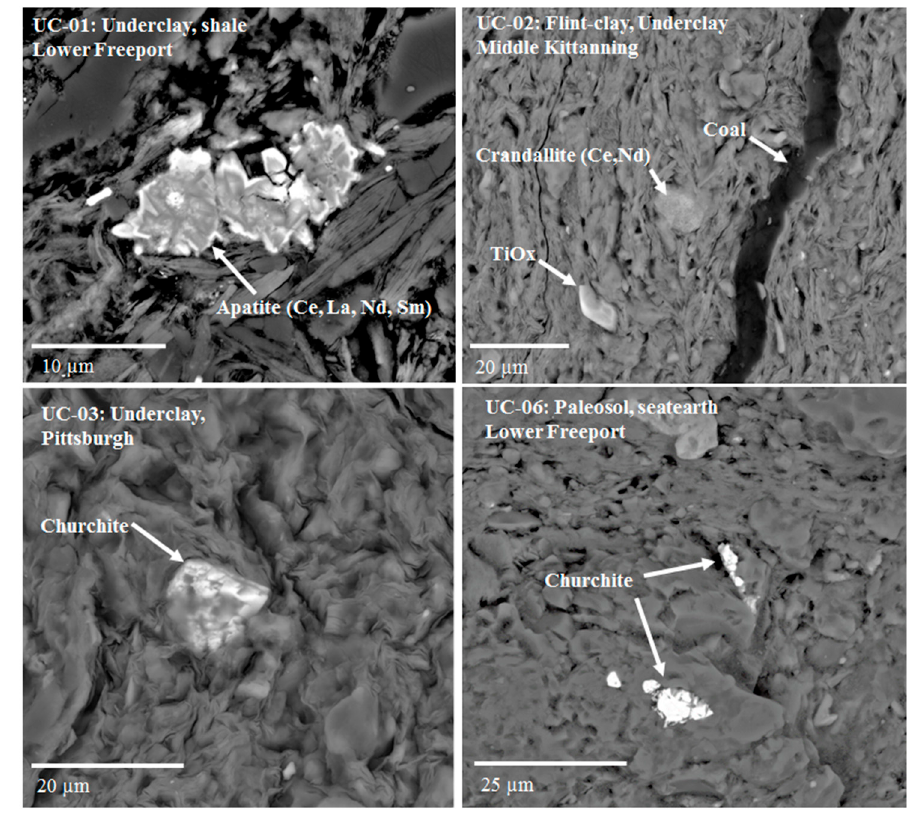
Figure 2. SEM micrographs of rock matrix and examples of rare earth elements (REE)-bearing minerals present in West Virginia underclay samples.